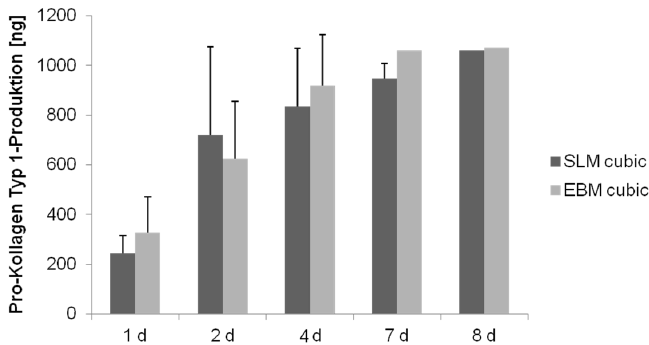
Figure 7. Collagen synthesis of human osteoblasts cultured under static conditions over eight days. Values are means ± SD. ( n ≥ 1): ANOVA Post-Hoc-LSD. Statistical significance levels ( p < 0.05).